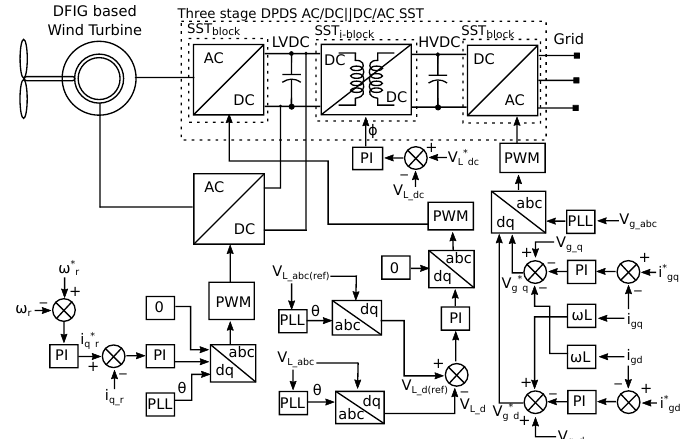
Figure 24. Application of SST in wind turbines as highlighted in [160].